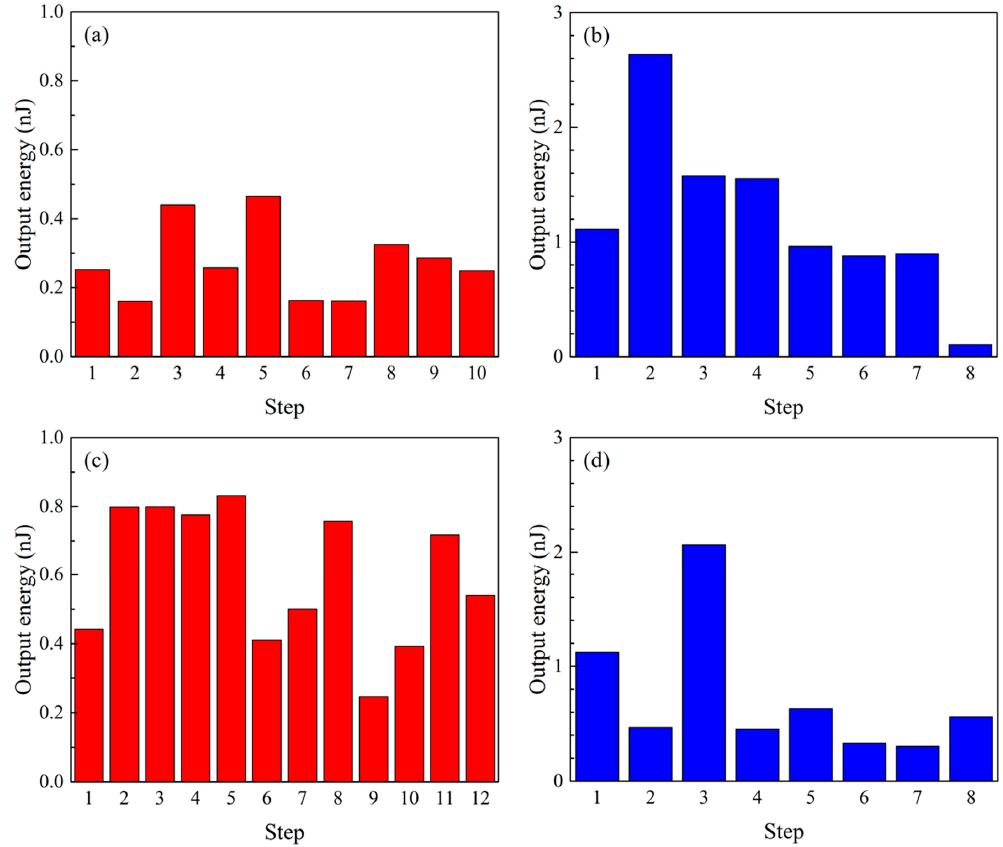
Figure 5. Output energy obtained by Fe–Co magnetostrictive fiber integrated shoes; ( a ) during the usual walking of subject 1, ( b ) during the usual walking of subject 2, ( c ) during walking with legs raised higher in subject 1, and ( d ) during the walking with legs raised higher in subject 2.